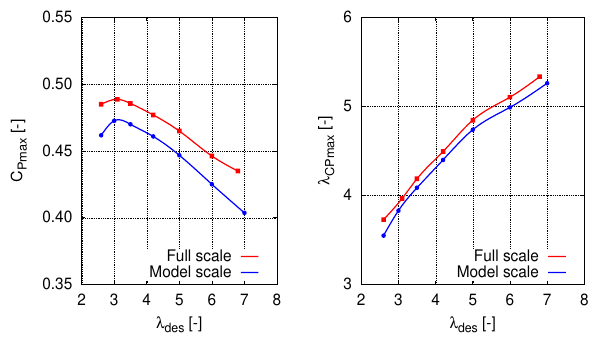
Fig. 24. Full-scale and model-scale turbine compared: C and λ CPmax (right) as function of λ des .